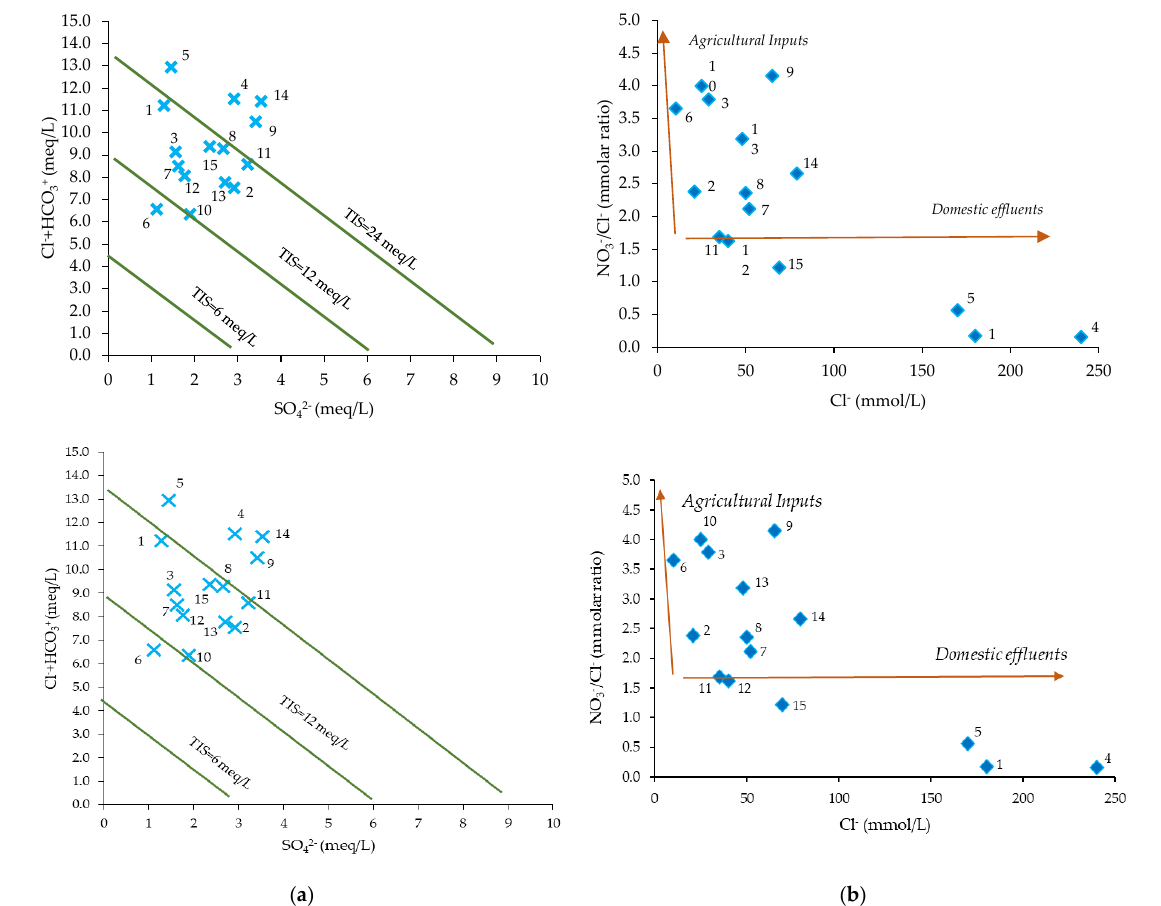
Water 2023 , 15 , x FOR PEER REVIEW Figure 4. TISTotal Ionic Salinity plot ( a ) and sources for Cl - and NO 3- ( b ). Figure 4. TISTotal Ionic Salinity plot ( a ) and sources for Cl − and NO 3 − ( b ). According to the Gibbs diagrams, represented in Figure 5, all chemical processes and the hydrogeochemical evolution of the studied waters have rock dominance. The correla- tion of high amounts of Cl − , SO 42− and HCO 3− characterizes the waters with high salinity. Figure 4a indicates the TIS distribution and classification of the studied water samples. The TIS diagram indicates that the majority of samples have a TIS of 12 meq/L, and only one sample (6) has a TIS of 6 meq/L. Less than 30% of the samples have a high TIS (=24 meq/L).